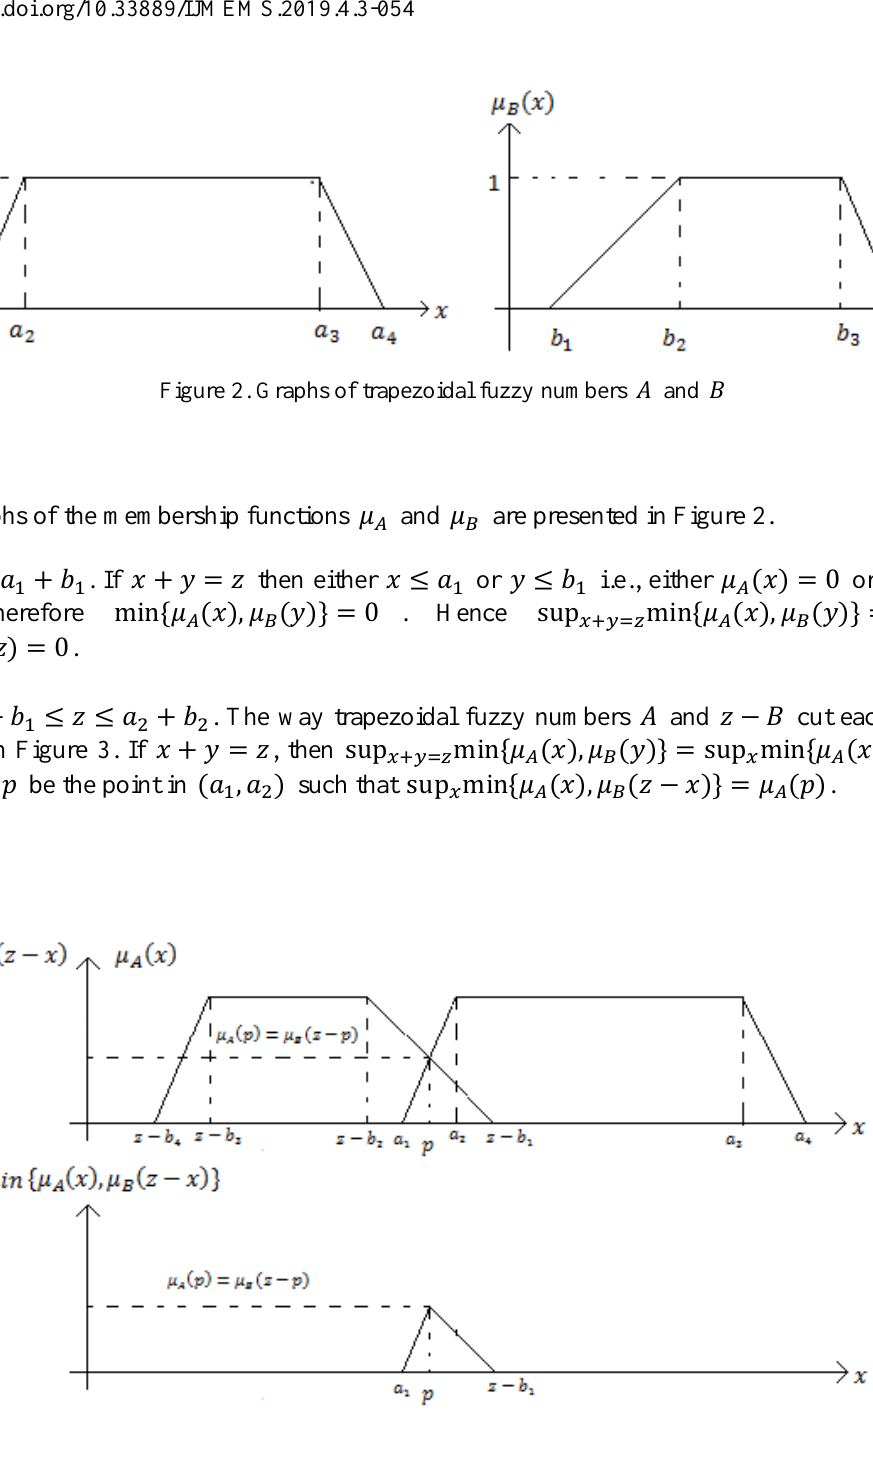
Figure 3. Graphs of the minimum of two trapezoidal fuzzy numbers 𝐴 and 𝑧 −